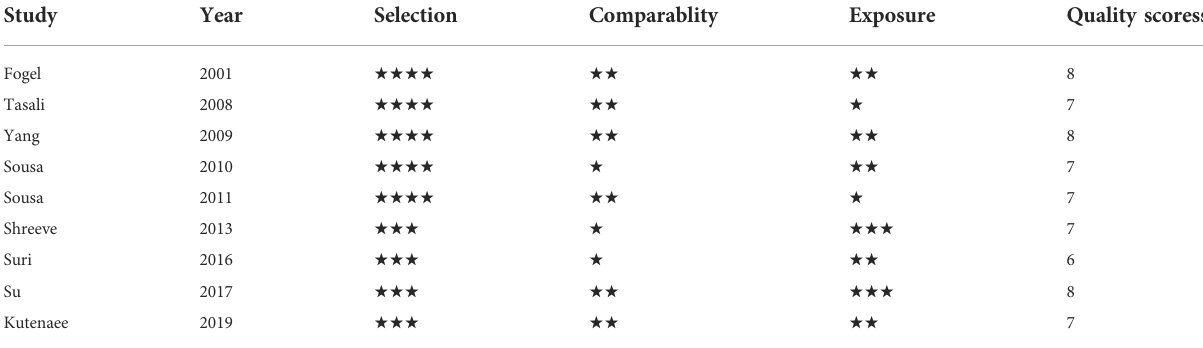
TABLE 2 Newcastle – Ottawa Scale of the included